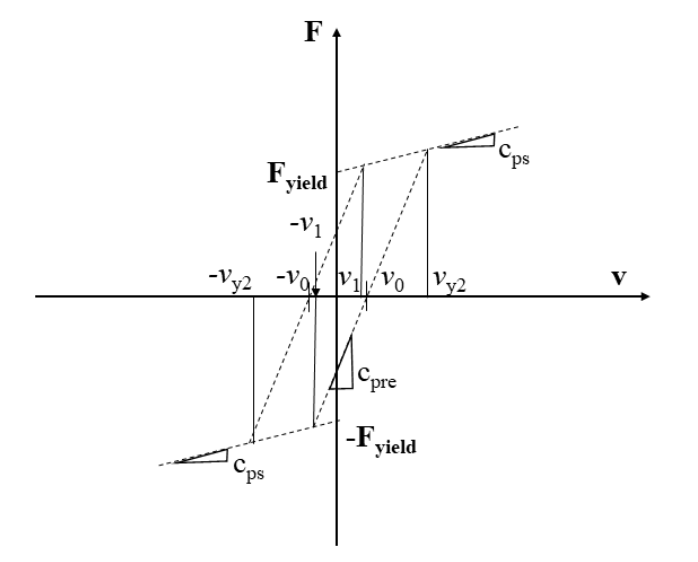
Figure 5. Force-Velocity diagram for the bi-viscous hysteretic